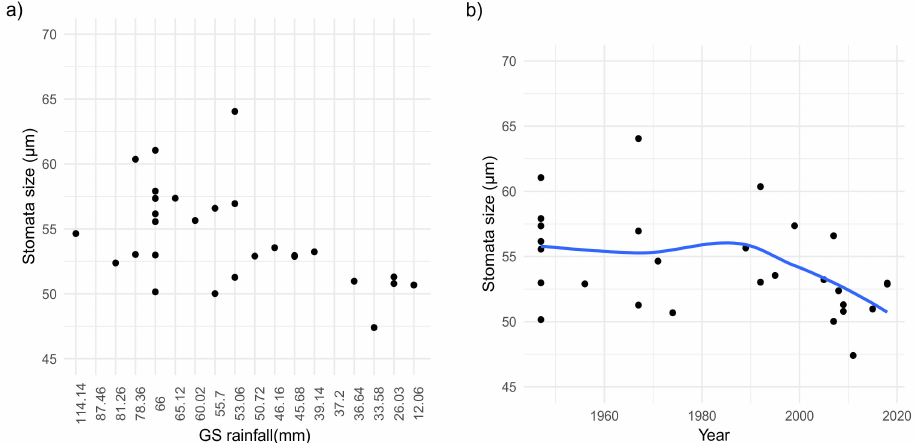
Figure 4. ( a ) Variations in stomatal size in response to rainfall regimes during the growing seasons throughout 72 years in S. carpetanus from Sierra de Guadarrama mountains; ( b ) overall variation in stomatal size in conserved specimens of S. carpetanus from Sierra de Guadarrama between 1946 and 2018. Blue lines represent the modeled data and the surrounding gray area indicates the estimated variation of the parameter, according to the